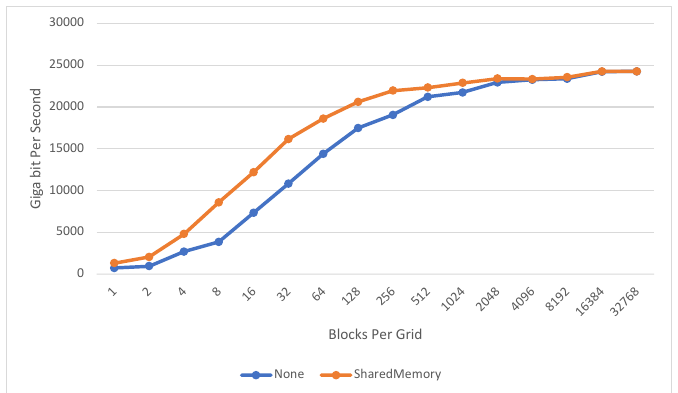
Figure 12. PRESENT-80 encryption: Comparison of using shared memory and not using shared